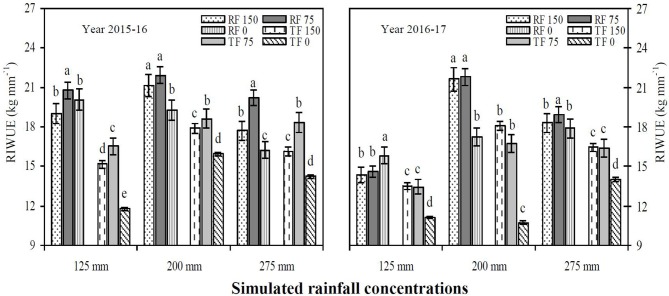
Rainfall irrigation water use efficiency (RIWUE) in 2015–16 and 2016–17. RF150: ridges covered with plastic film mulch and 150 mm deficit irrigation; RF75: ridges covered with plastic film mulch and 75 mm deficit irrigation; RF0: ridges covered with plastic film mulch and 0 mm deficit irrigation; TF150: traditional flat planting and 150 mm deficit irrigation; TF75: traditional flat planting and 75 mm deficit irrigation; TF0: traditional flat planting and 0 mm deficit irrigation. Three different simulated rainfall intensity 275, 200, and 125 mm were used. Different lowercase letters indicate significant differences at P < 0.05, and the error bars represent the standard error of the mean (n = 3).